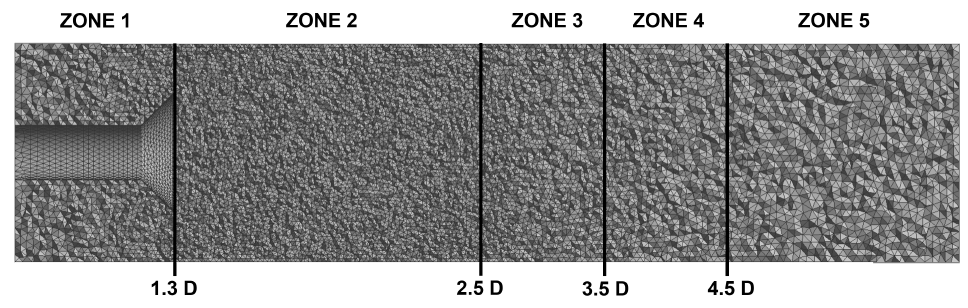
Figure 2. View of Mesh # 3 with zone partitioning for grid